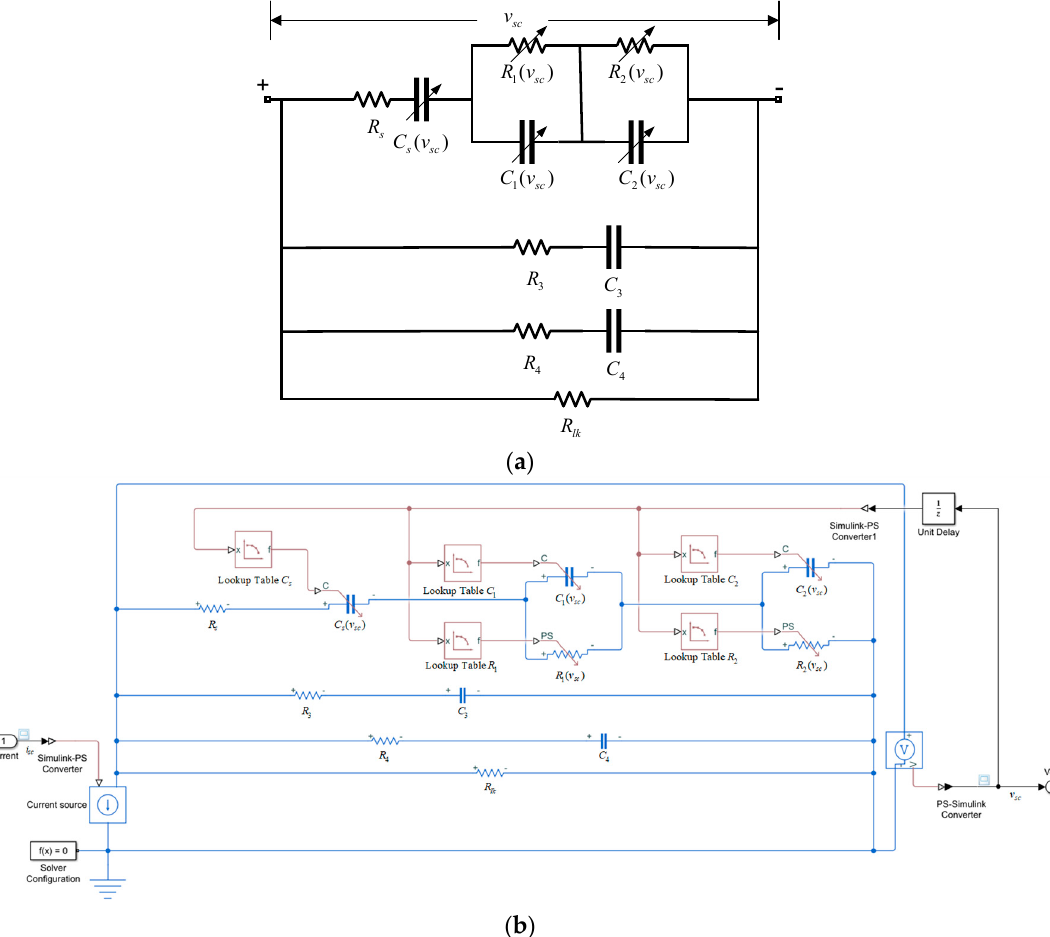
Figure 3. Series model: ( a ) Electric circuit; ( b ) Simscape implementation.